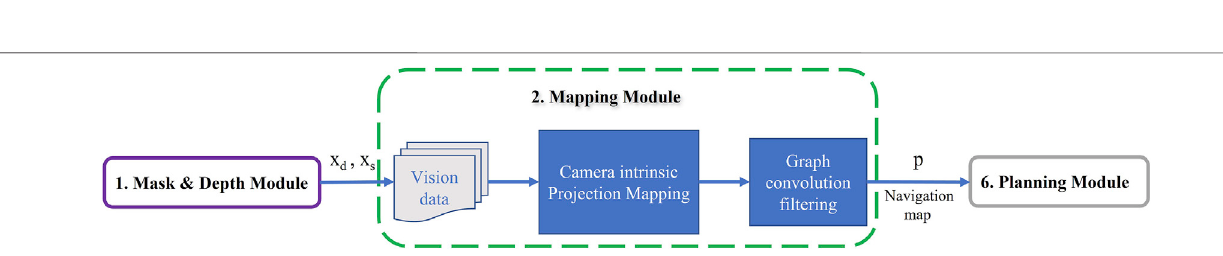
FIGURE 3 | Mask and Depth Module: Predicts segmentation mask and depth map from robot ’ s current observation.